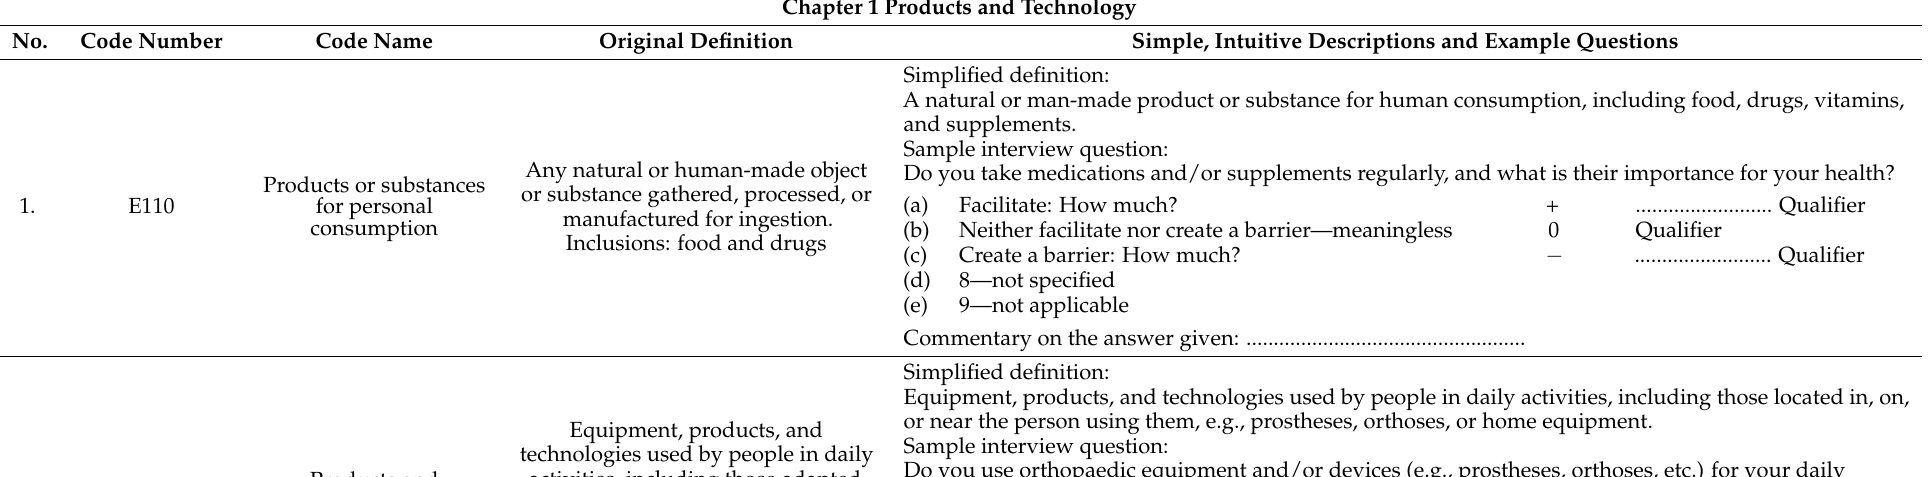
Table 3. The Polish final version of the simple, intuitive description of the ICF categories and example